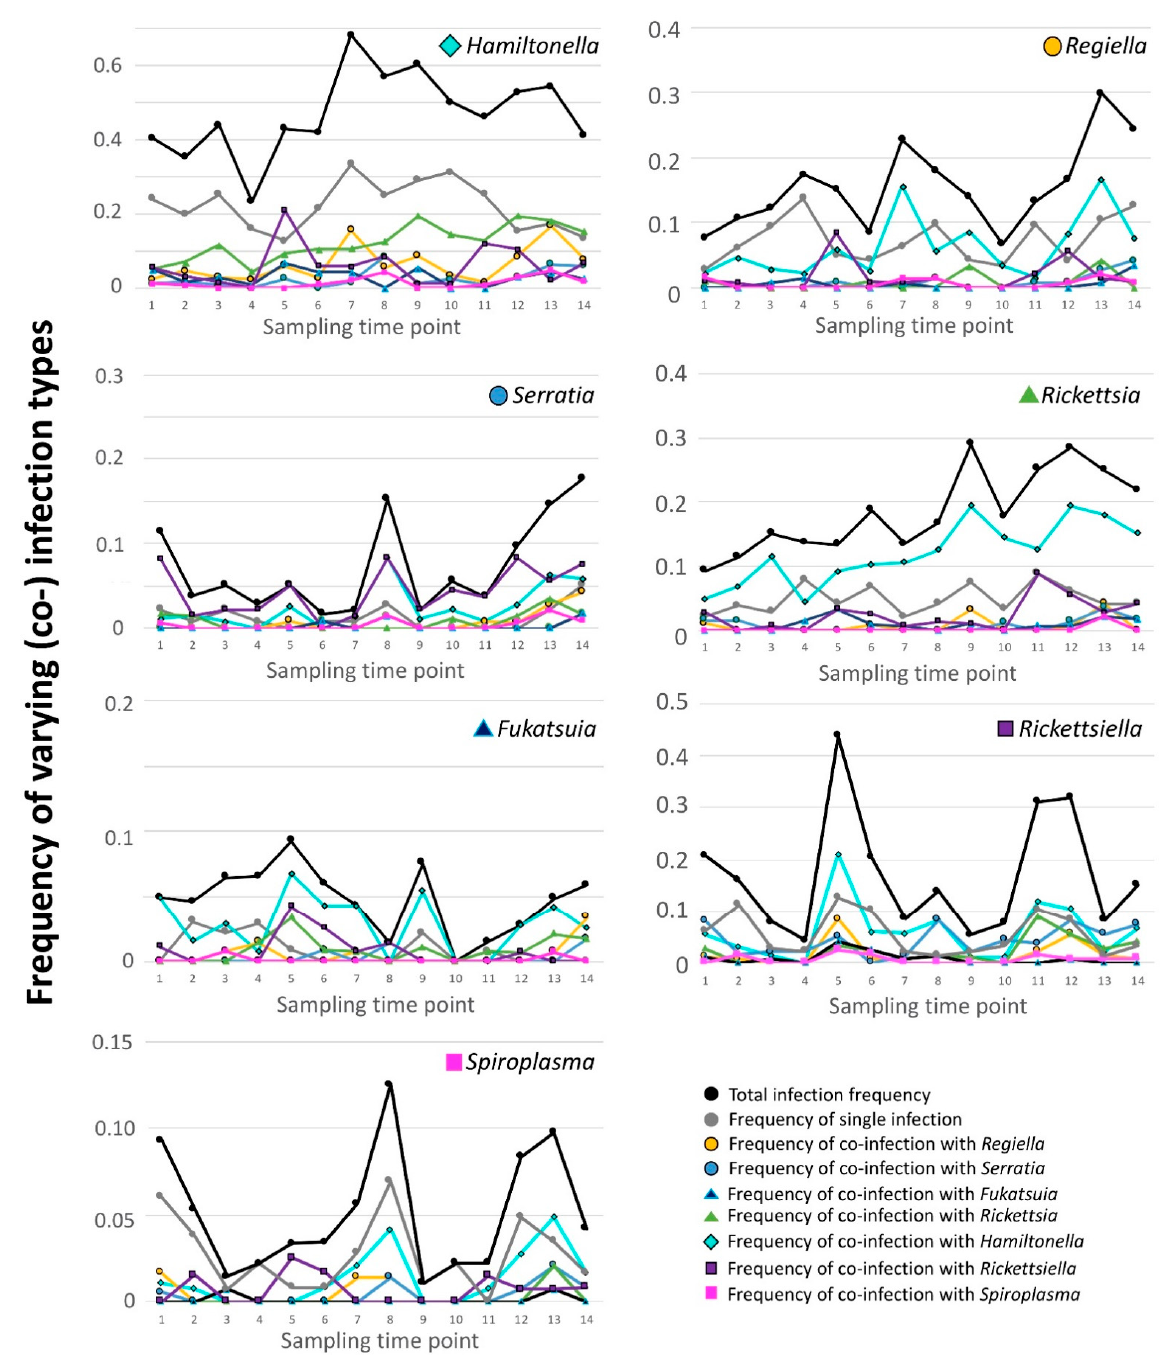
Figure 3. Co-infection contexts for facultative symbionts across the 2012 field season. Shown here are results of diagnostic PCR screening for each of seven facultative symbionts—in total and in relation to the presence of other symbionts in the same aphid hosts. All datapoints represent pooled frequencies across all sampled fields from the given time. Solid black lines represent total frequencies. Colored lines represent the frequencies of aphids harboring co-infections with the focal symbiont and other facultative symbionts. Gray lines represent the frequencies of the focal symbionts in aphids with no other co-infecting facultative symbionts (“single infections”). Several symbionts underwent large frequency shifts across paired time points, separated by only 2-weeks. These showed frequent consistency/parallels across replicate fields (Figure S1). Among these, shifts for Hamiltonella at times 3–4 and 6–7 were at least partially comprised of changes in the prevalence of single infections, arguing against the possibility that Hamiltonella hitchhiked in aphids with a second symbiont yielding a phenotype under stronger selection. Single infection trajectories were somewhat muted, but parallel to those